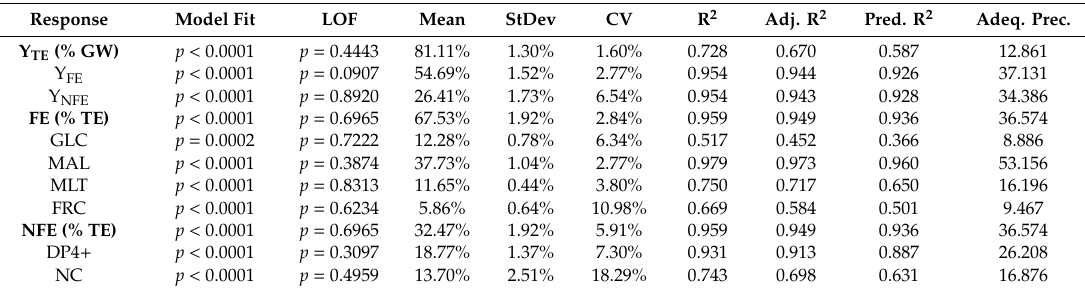
Table 4. Compiled response model fit